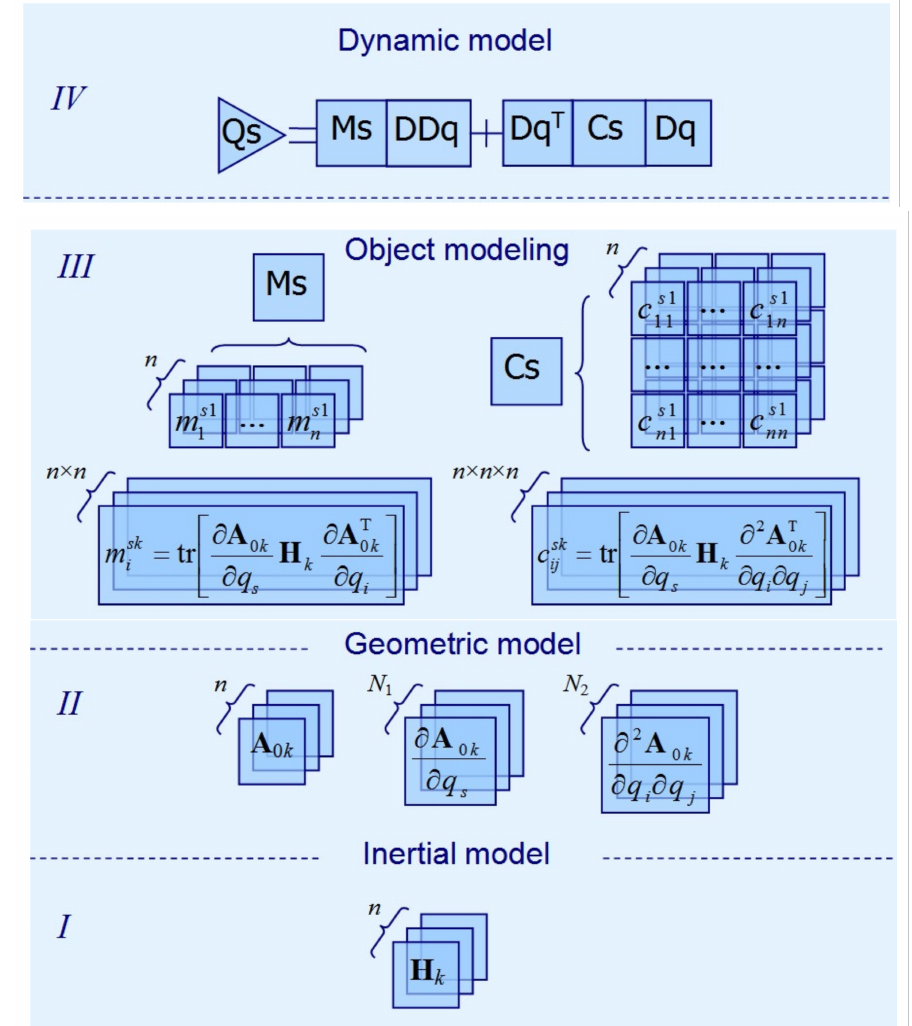
Figure 13. Levels of the dynamic model parallel computing